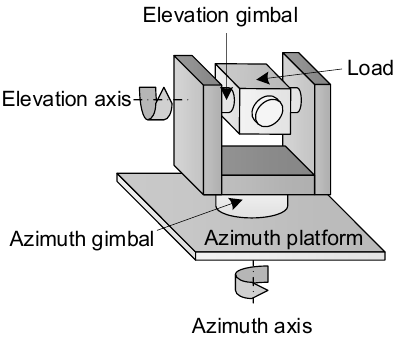
Figure 1. The structure of the two-axis inertial stabilization platform.